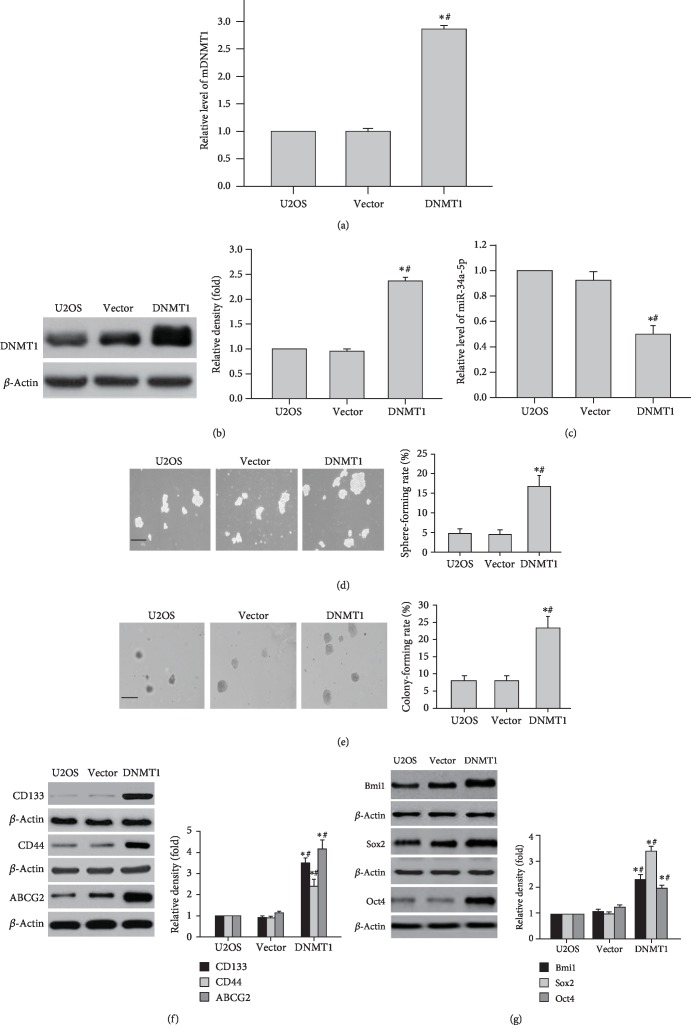
Effects of overexpressing DNMT1 on the stemness feature in U2OS cells. (a, b) DNMT1 mRNA and protein were detected by qRT-PCR and immunoblot in U2OS cells transfected with DNMT1 cDNA, with β-actin serving as a loading control. (c) qRT-PCR analyzed the miR-34a-5p level in U2OS cells transfected with DNMT1 cDNA. (d) Representative images of the spheres in U2OS cells transfected with DNMT1 cDNA (left) (scale bar, 200 μm) and the sphere-forming rates (right). (e) Representative images of the colonies in U2OS cells transfected with DNMT1 cDNA (left) (scale bar, 200 μm) and the colony-forming rates (right). (f) CD133, CD44, and ABCG2 proteins in U2OS cells transfected with DNMT1 cDNA (left) and their densitometric analysis (right), with β-actin serving as a loading control. (g) Bmi1, Sox2, and Oct4 were assessed in U2OS cells transfected with DNMT1 cDNA. ∗p < 0.05 (n = 3) vs. U2OS cell; #p < 0.05 (n = 3) vs. vector control.